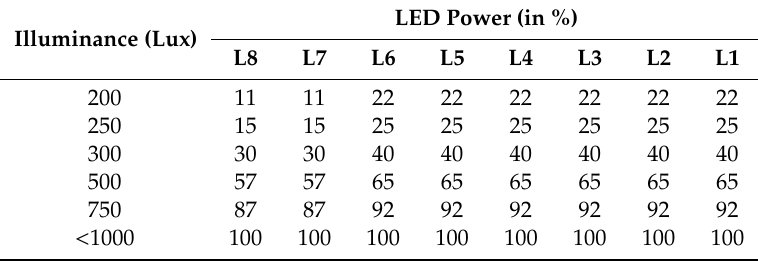
Table 5. Simulation results from sub-scenario C, 4:00 p.m., 10 November